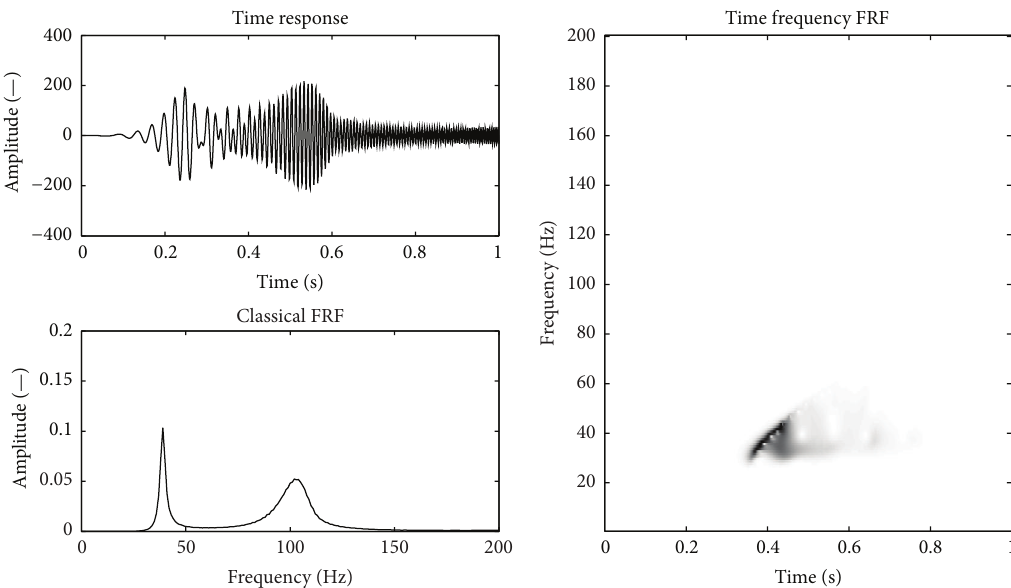
Figure 8: Simulated results obtained for the chirp excitation in the time, frequency, and combined time-frequency